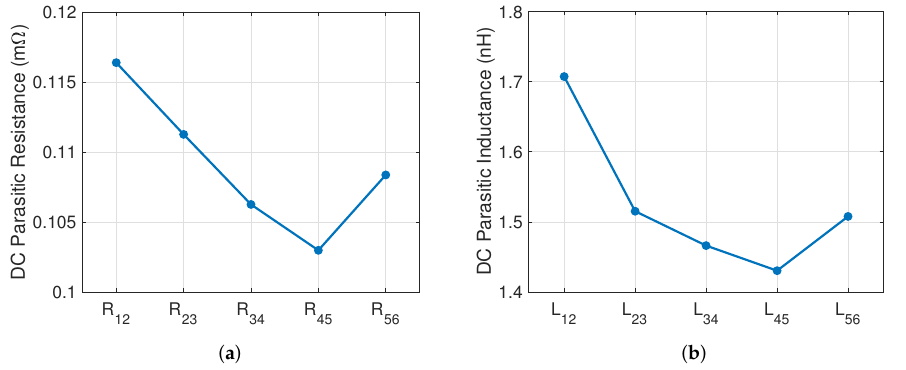
Figure 8. Estimation of parasitic resistance and inductance: ( a ) AC parasitic resistances, ( b ) AC parasitic inductances, ( c ) DC parasitic resistances, and ( d ) DC parasitic inductances.